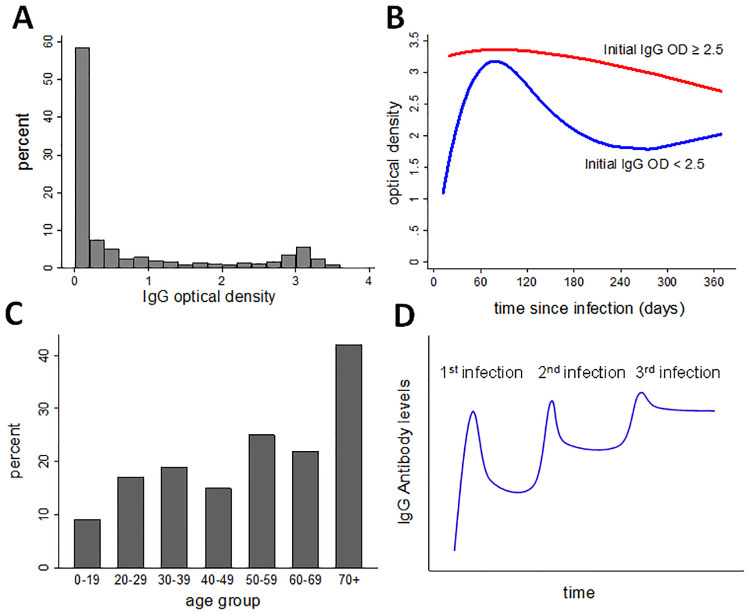
Sero-epidemiology of scrub typhus: A) IgG antibody levels expressed as ELISA optical density (OD) from cross-sectional study in the general population in the study setting (from [12]); B) IgG antibody response after infection in cases with high initial IgG antibody levels (red) and low initial IgG antibody levels (blue), from [14]; C) IgG sero-prevalence by age (from [11]); D) hypothesised building-up of IgG antibody levels over multiple scrub typhus infections.